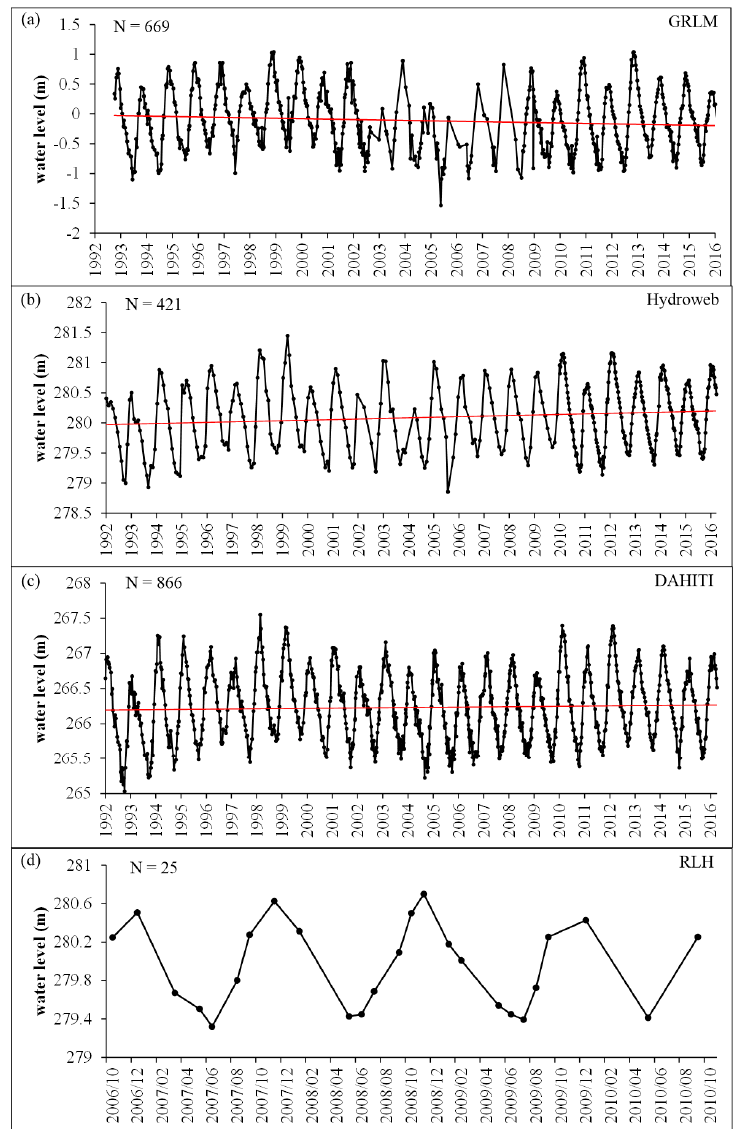
Figure 5. Water level variations retrieved from four altimetry products: GRLM ( a ), Hydroweb ( b ), DAHITI ( c ), RLH ( d ). The red lines indicate the trend of variation.